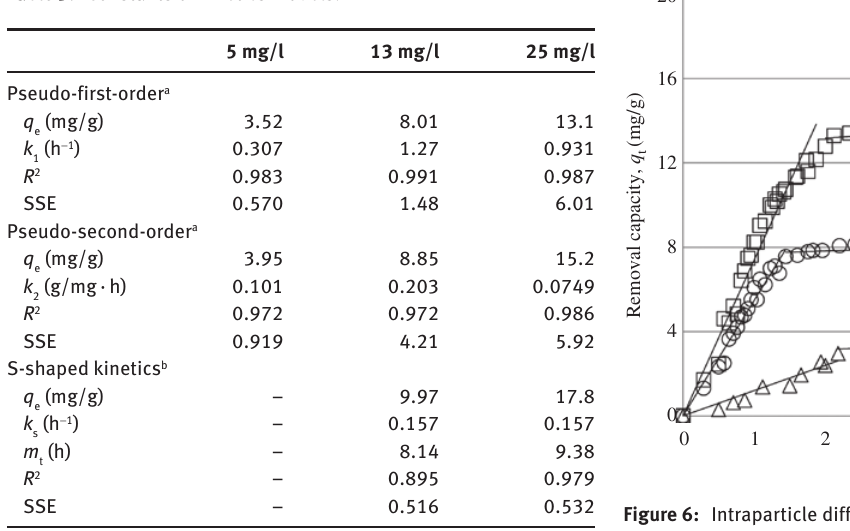
Table 3: Constants of kinetics models.